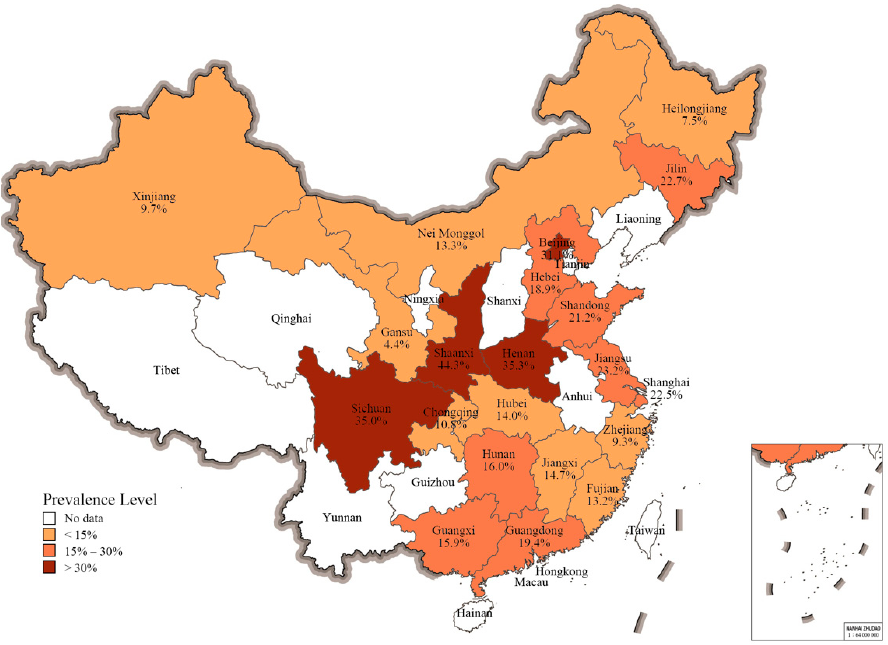
Figure 3. The pooled prevalence of Salmonella in raw poultry meat from 21 Chinses provincial regions based on the included reports.